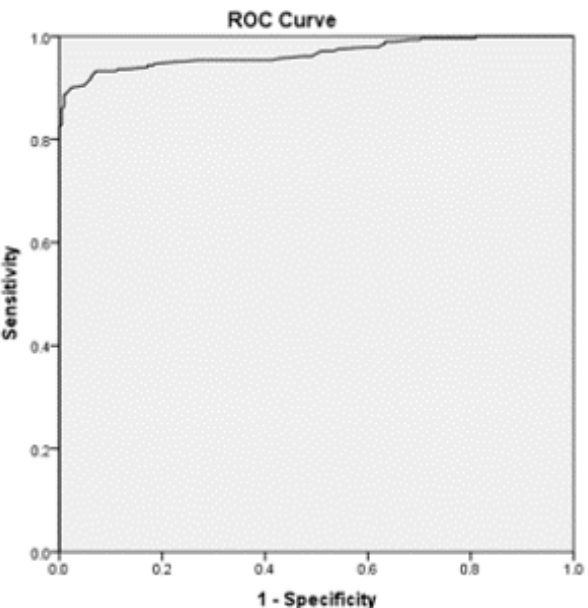
Figure 5. Receiver operating characteristic (ROC) curve of best cut-off value of serum CRP (CRPs), and its statistical characteristics, for discrimination between transudative pleural effusion and exudative pleural effusion. CRPs best cut-off value = 20.5 mg/L, AUC = 97% (95% CI: 95.2–98.2), sensitivity = 93.3%, specificity = 93.0%, total accuracy = 93.1%, PPV = 93.3%, NPV = 93%, odds ratio = 179.9 (risk for exudate when CRPs value > 20.5 mg/L), p < 0.0001.